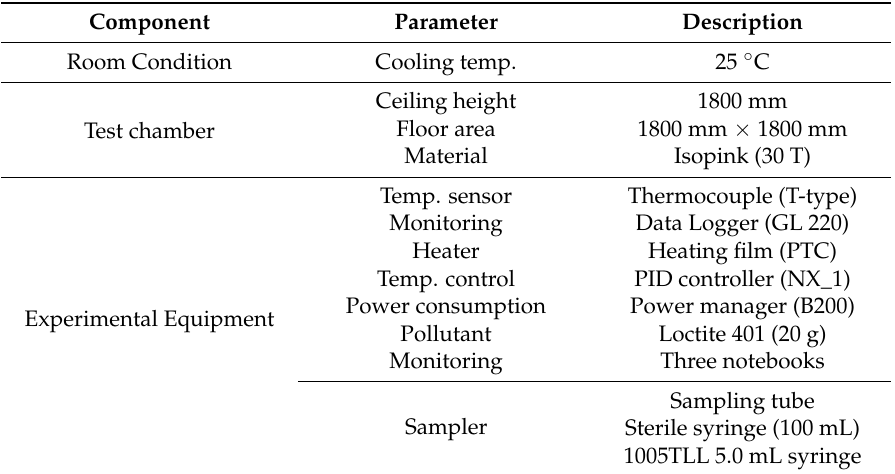
Table 2. Details of the experimental apparatus.